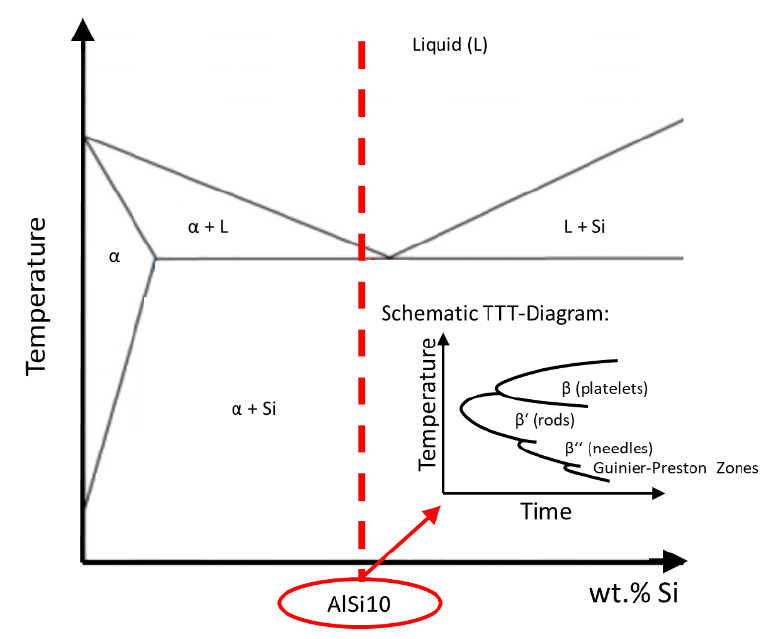
Figure 1. Schematic phase and TTT diagram of Al–Si alloys, reproduced and adjusted from [7–9]. LPBF AlSi10Mg components can achieve a relative density larger than 99.8%